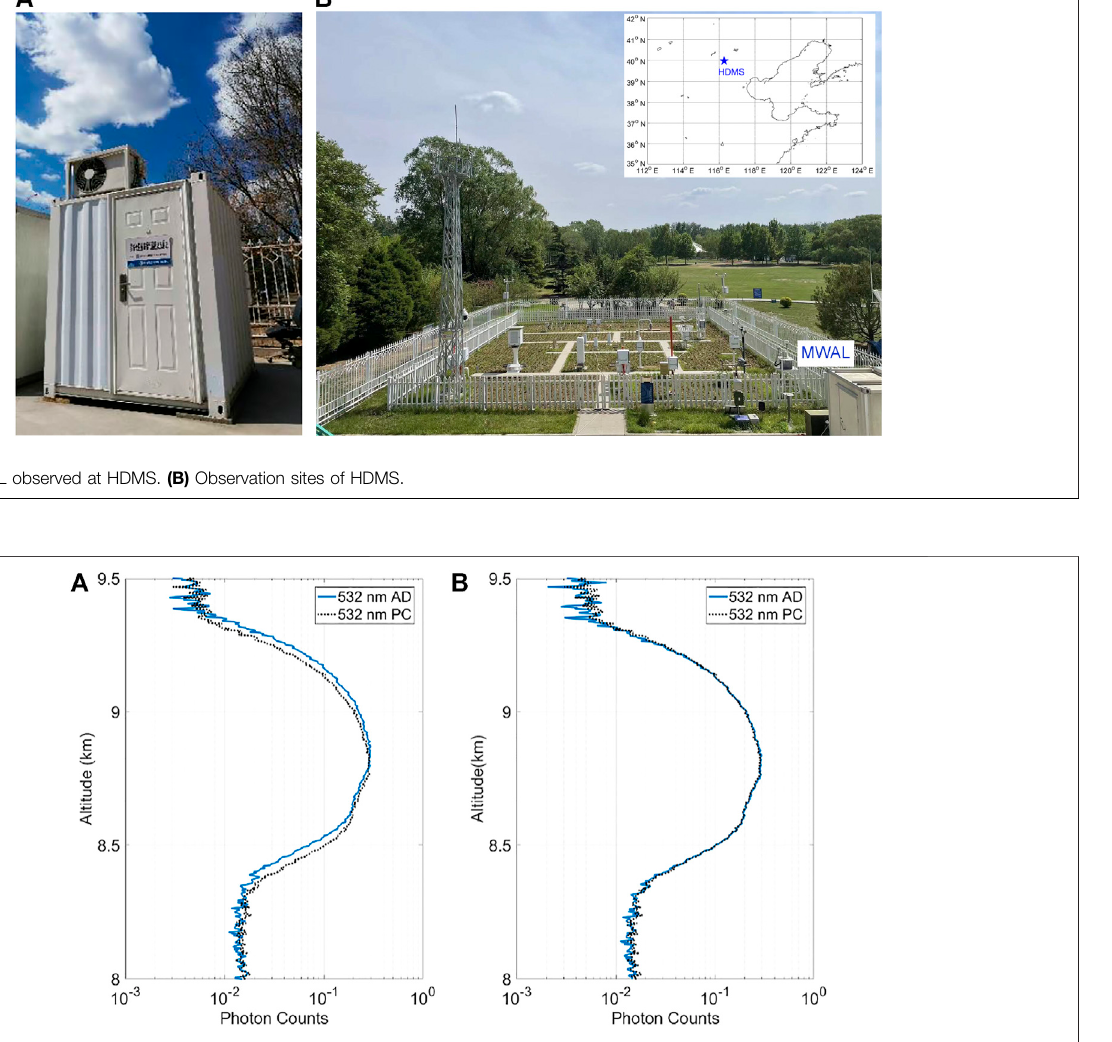
FIGURE 3 | (A) The data of AD mode and PC mode before data correction. (B) The data of AD mode and PC mode after data